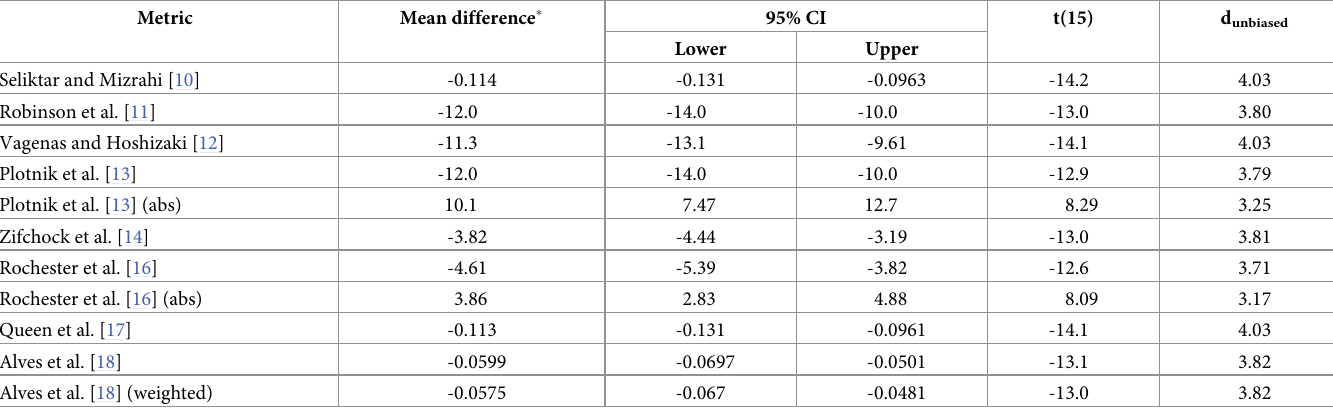
Table 3. Swing time